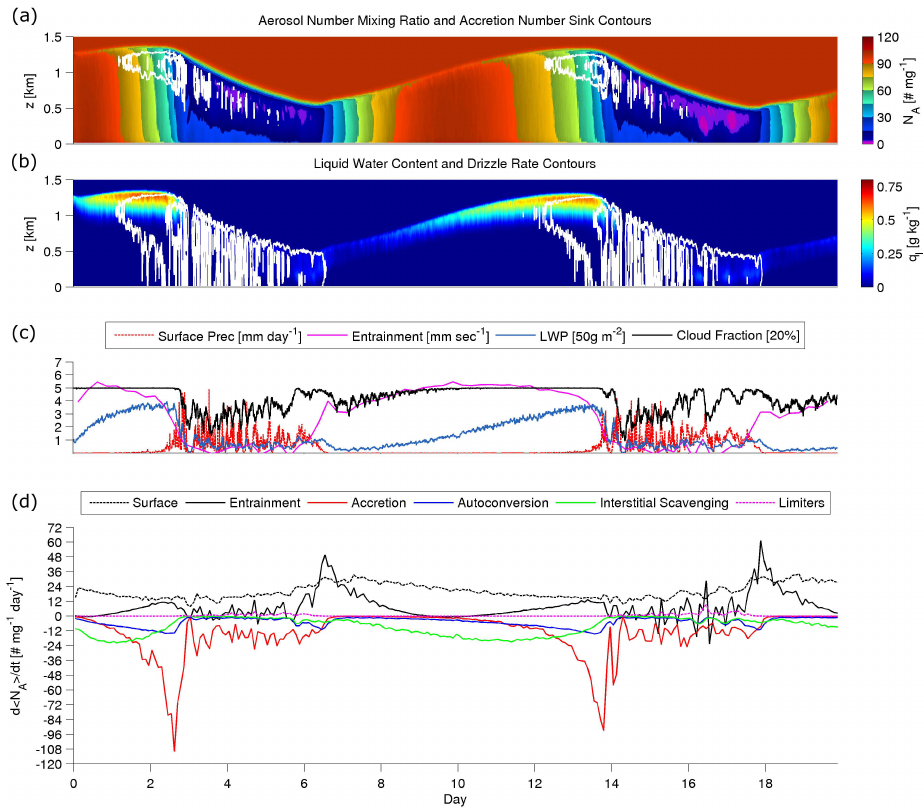
Fig. 4. Time-height plots and time series for run W5/NA100. (a) Total aerosol number concentration N a with contours [75 225mg − 1 day − 1 ] | of accretion number sink d N d Accr . (b) Liquid water content q l and contours of drizzle flux [0.2 2.0mmday d t precipitation, entrainment, liquid water path, and cloud fraction. (d) MBL averaged aerosol budget tendencies.